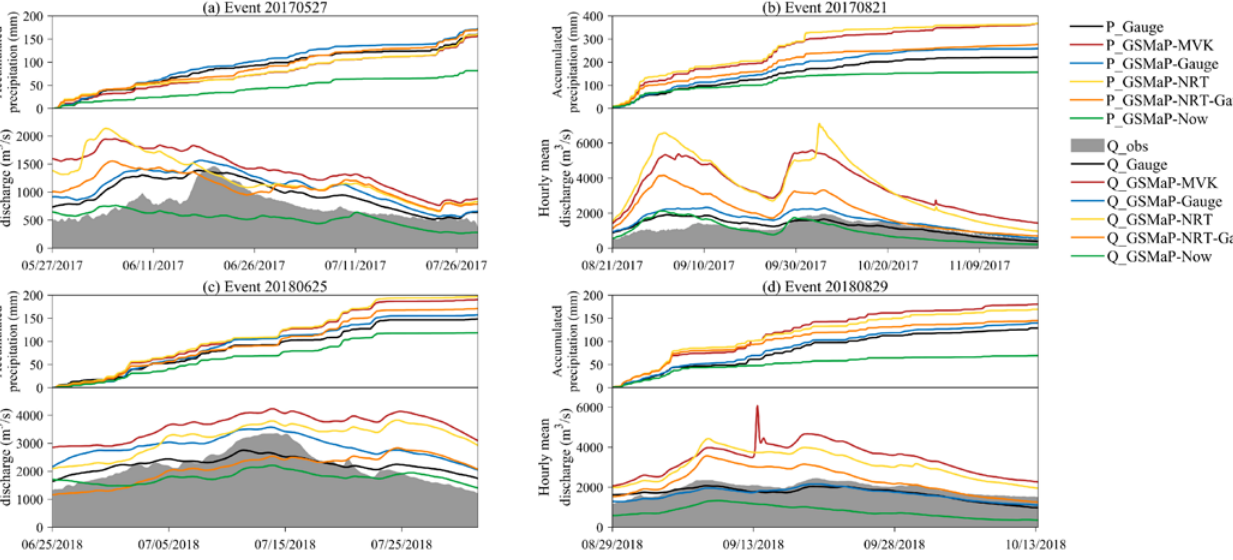
Figure 13. Observed and simulated hourly hydrographs of the four historical flood events in 2017 and 2018 at the Tangnaihai hydrological station using the rain-gauge-based precipitation data and the five GSMaP SPPs (the variables shown in this figure are as same as those in Figure 9). Table 4. Performance of flood event simulations at the Tangnaihai streamflow station using the rain-gauge-based precip- itation data and the five GSMaP SPPs as model inputs.